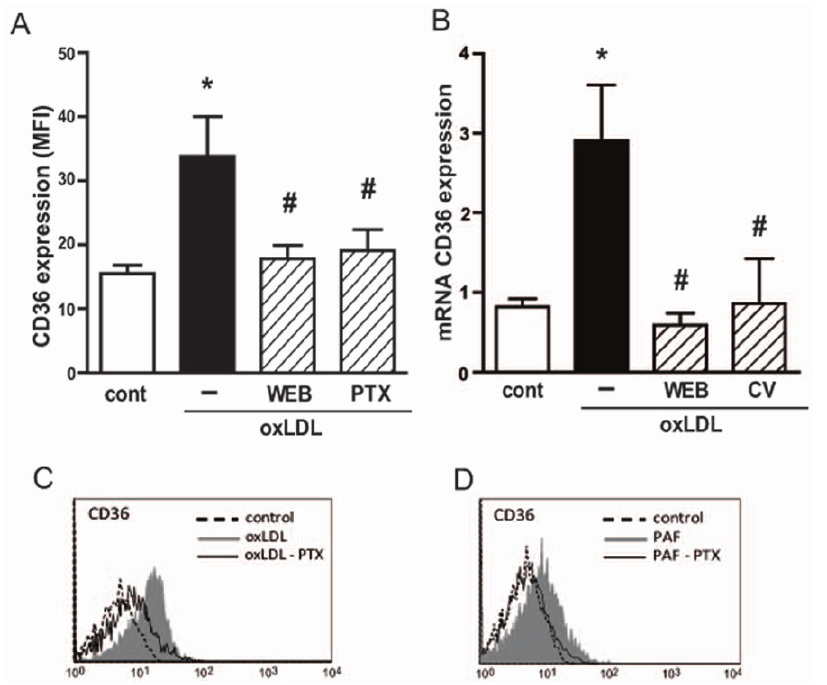
Figure 4. PAFR and G a i-coupled protein is required for upregulation of CD36 protein and mRNA expression. Adherent human monocytes/macrophages were treated with WEB2170 (50 m M, 30 min) or with pertussis toxin (PTX - 600 ng/mL, 18 h) and then stimulated with oxLDL (30 m g/mL) or PAF (10 2 6 M). The expression of CD36 was measured by FACS after 24 h (A, C and D) and the mRNA levels after 5 h (B). Data are presented as mean 6 SEM of the mean fluorescence intensity of five donors (A–B) or one representative experiment (C–D). * p , 0.05 comparing oxLDL stimulated with non-stimulated cells (cont). # p , 0.05 comparing cells treated with PTX, WEB2170 or CV3988, with non-treated cells.